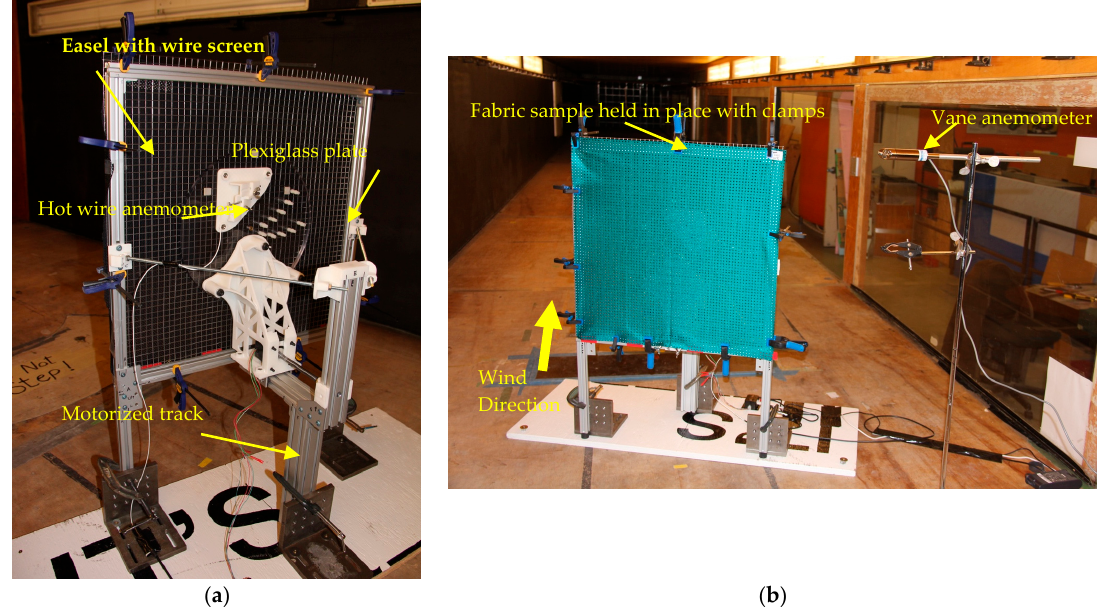
Figure 1. ( a ) Rear view of airflow measurement device; ( b ) Front (wind facing) view of the airflow measurement device.